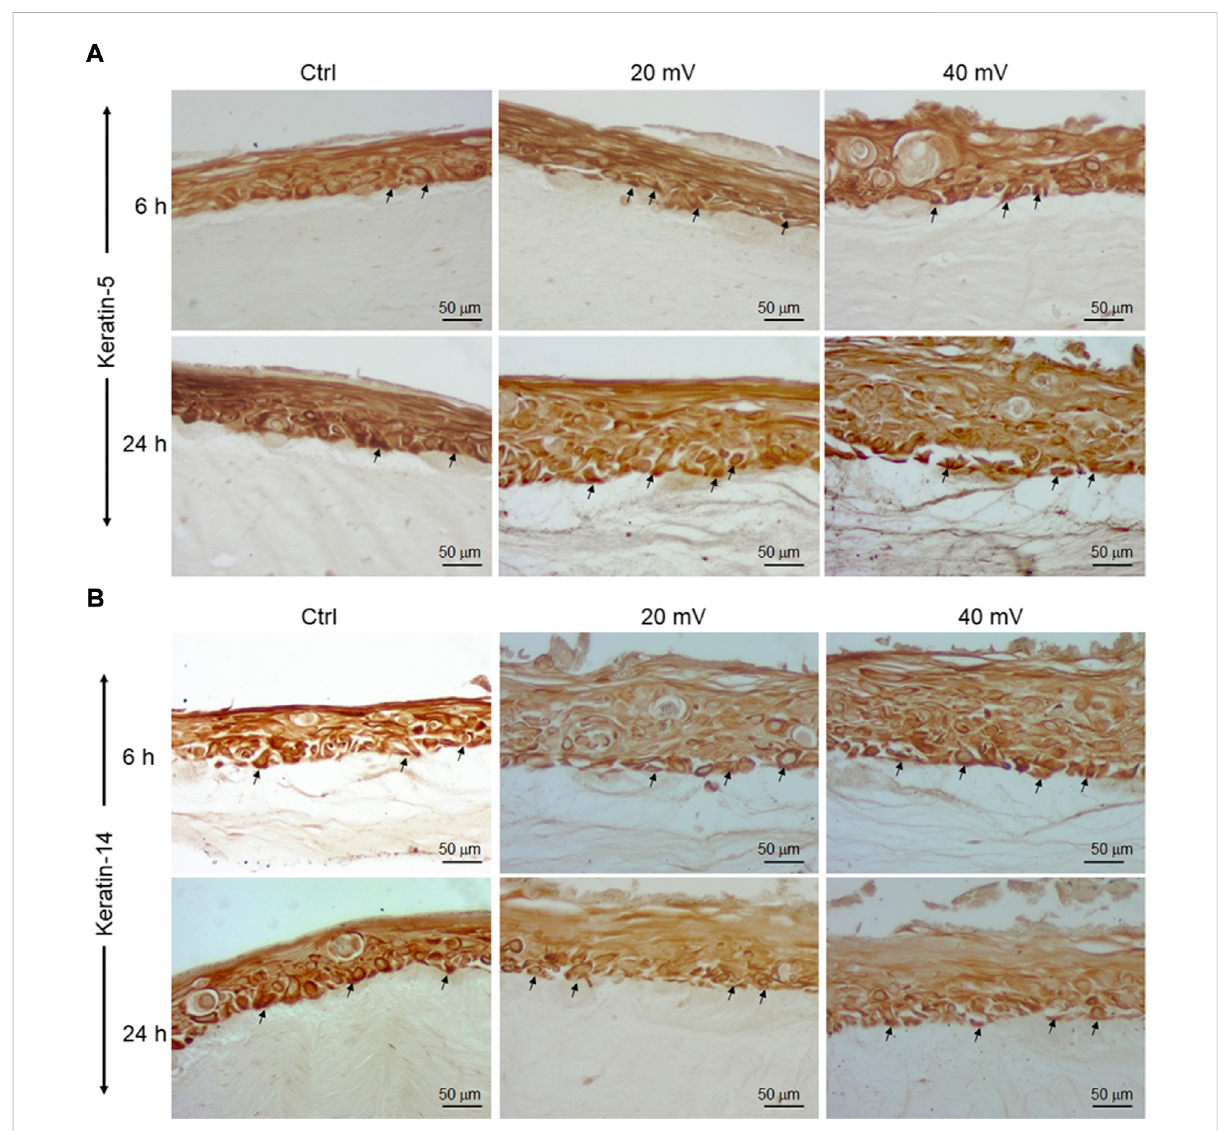
K5 (A) and K14 (B) positive cells in DHSE after exposure or not to ES. The DHSEs were exposed for 6 and 24 h to 20 mV/mm or 40 mV/mm. Tissue sections were stained with speci fi c antibodies to K5 and K14, respectively. Photos are representative of 3 different experiments, with each condition performed in triplicate. Arrows showed the stained cells at the basal and suprabasal